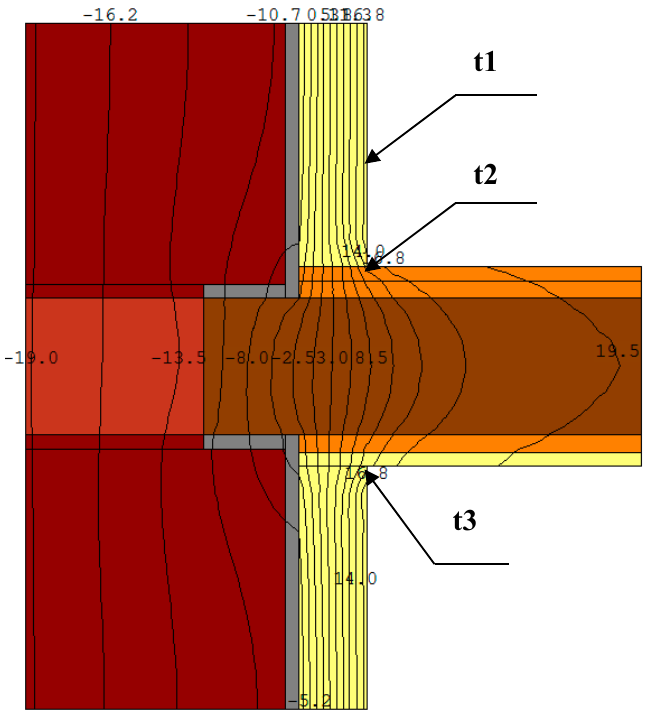
Figure 12. Distribution of isotherms for variant C.